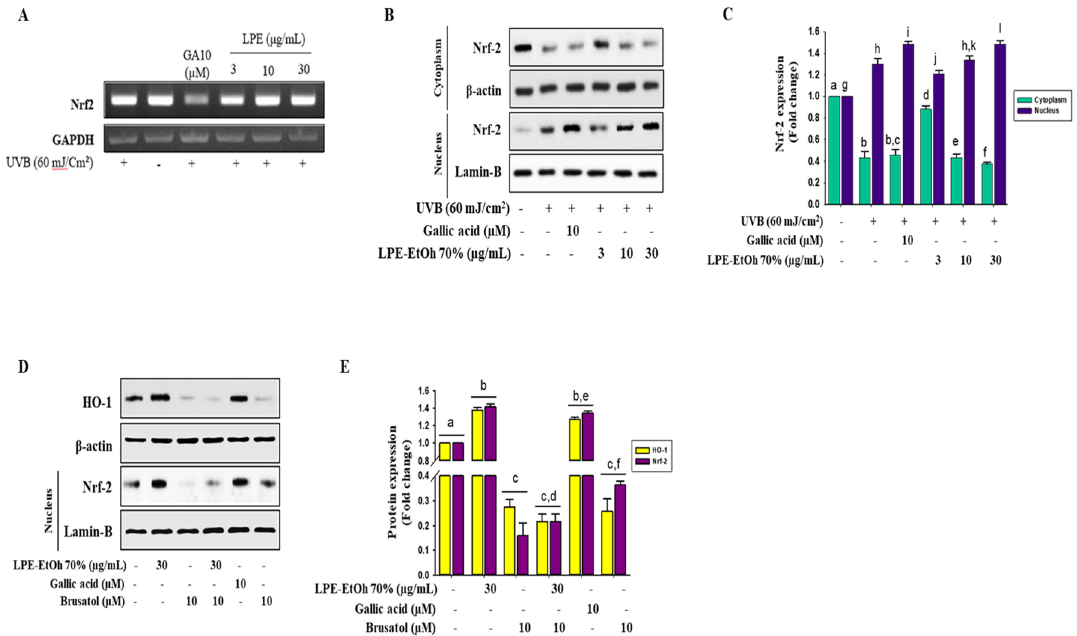
Figure 5. Effect of ethanol 70% extract Lablab purpureus L. (LPE) on Nrf2-mediated HO-1 expression. HaCaT cells were pretreated with 2 µL of LPE 30 µg/mL for 24 h and UVB 60 mJ/cm 2 . The mRNA expression ( A ) and protein expression of Nrf2 in cytoplasm and nucleus fractions ( B ) were analyzed by RT-PCR and Western blotting, respectively. Band intensity analysis was performed by image J software ( C ). HaCaT cells were pretreated with and without LPE 30 µg/mL, gallic acid (10 µM) and Nrf2 inhibitor (brusatol 10 µM) for 24 h and Nrf2 protein from nucleus and HO-1 protein in whole lysate were measured by Western blotting ( D ). Band intensity analysis was performed by image J software ( E ). Statistical values are expressed as the mean ± SD ( n = 3). All the tests were performed in triplicate. Different letters stand for statistically significant each other ( p < 0.05) performed by one-way ANOVA followed by Tukey’s test.